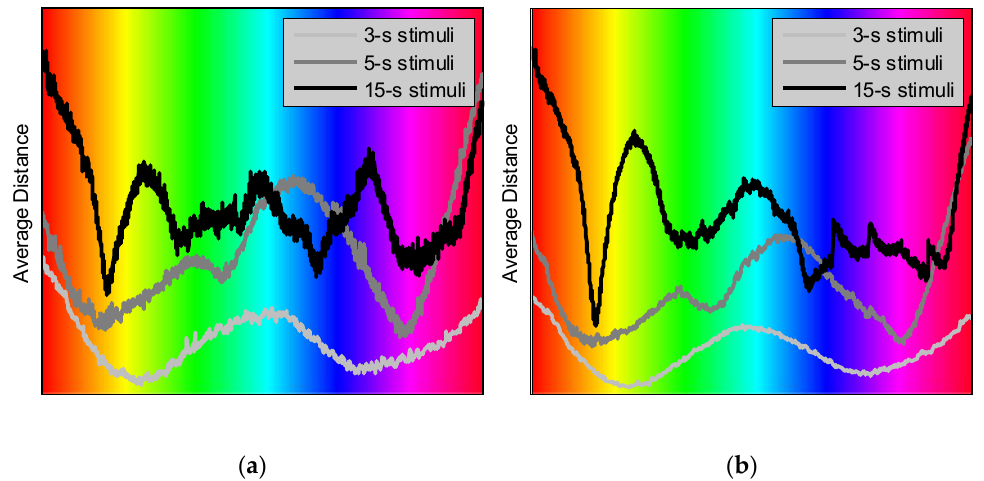
response is registered from Parieto ‐ Temporal region. Frontal region produces a